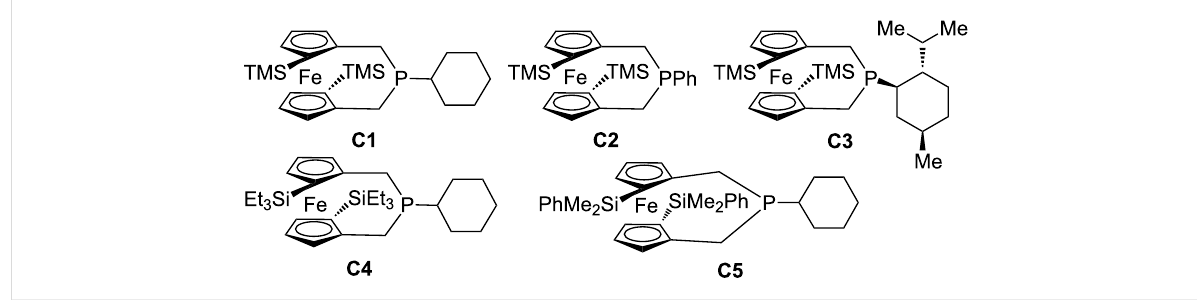
Figure 3: Cyclic chiral phosphines based on ferrocene skeletons.